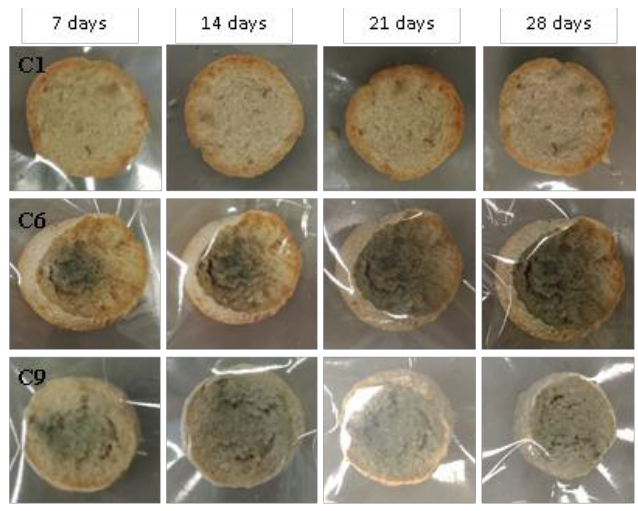
temperature for 7, 14, 21, and 28 days.